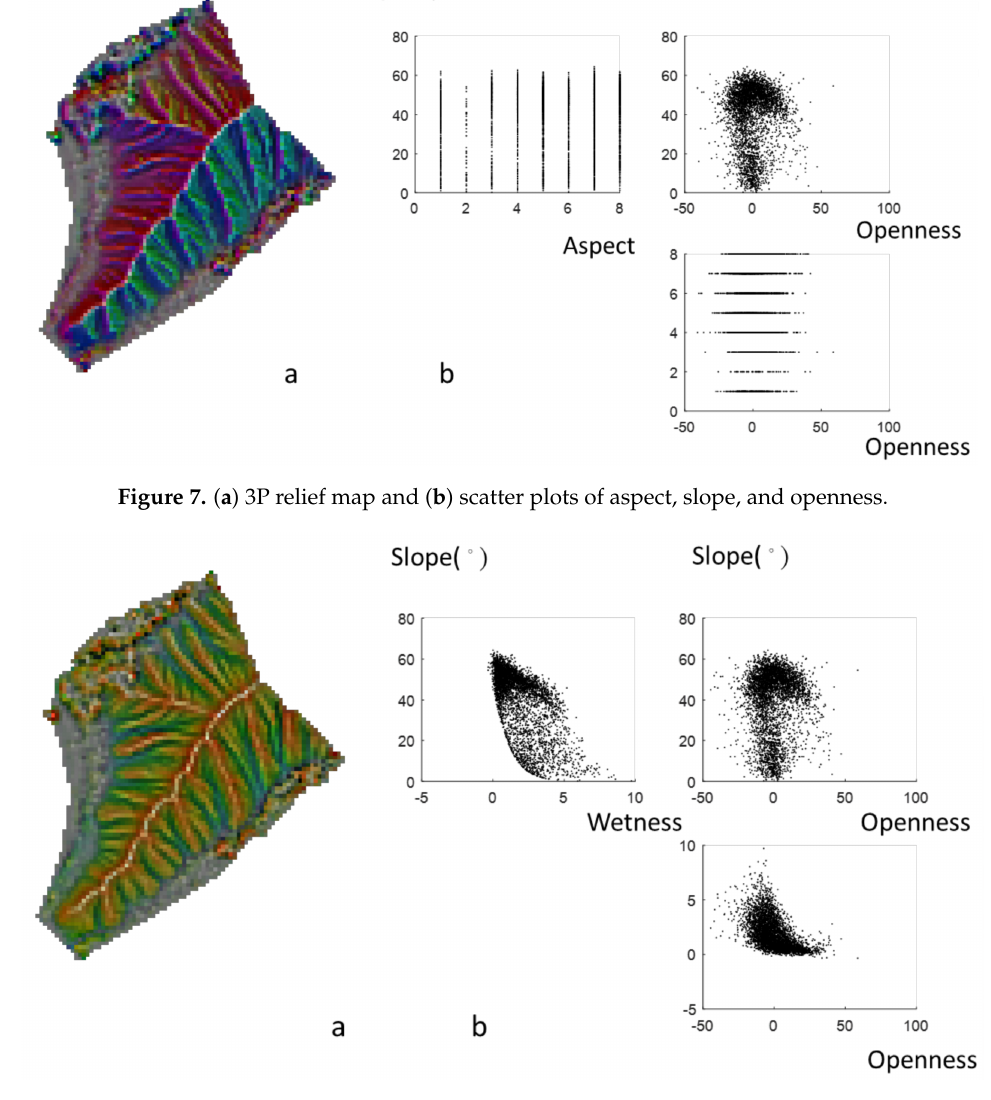
Figure 8. ( a ) 3P relief map and ( b ) scatter plots of wetness, slope, and